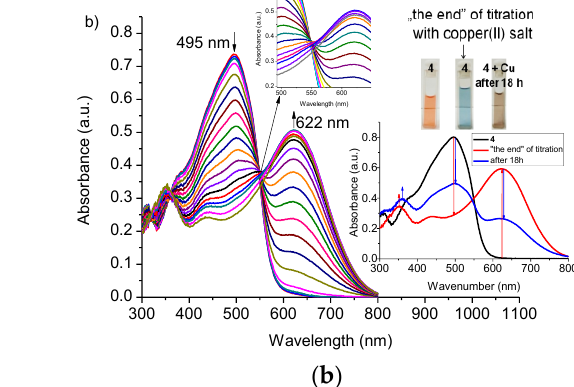
Figure 7. Changes in UV – VIS spectra of 4 upon titration with: ( a ) nickel(II) (c 4 = 3.75 × 10 − 5 M, c Ni = 0 – 1.35 × 10 − 3 M) — band of the highest absorbance at 567 nm corresponds to absorption spectrum of titrated solution registered after 18 h; ( b ) copper(II) (c 4 = 3.75 × 10 − 5 M, c Cu = 0 – 4.74 × 10 − 5 M) perchlorates in acetonitrile. Insets: Color change of solutions and change of UV – VIS spectrum for 4 — Cu system after 18 h.